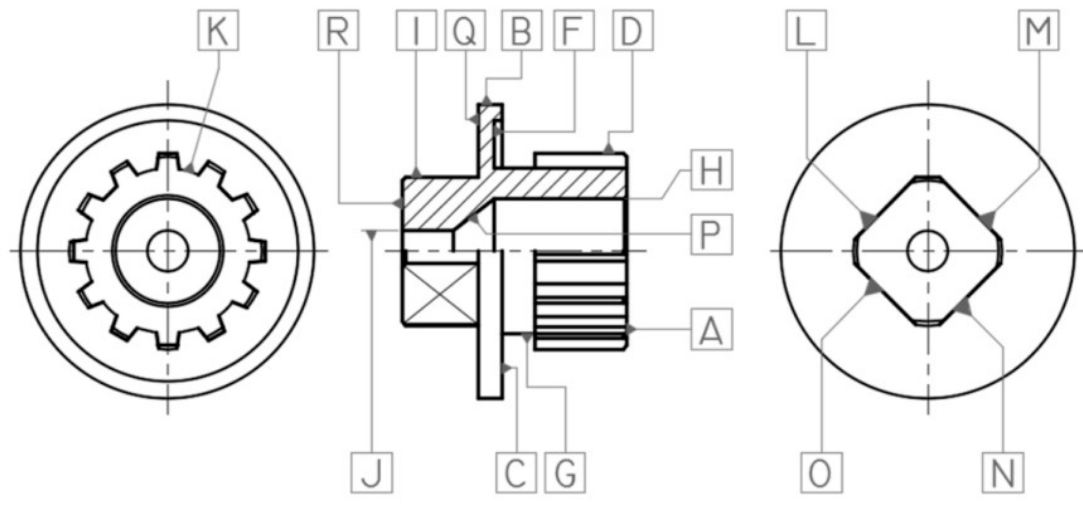
Figure 5. Letter of the surface on the piece [3,13].